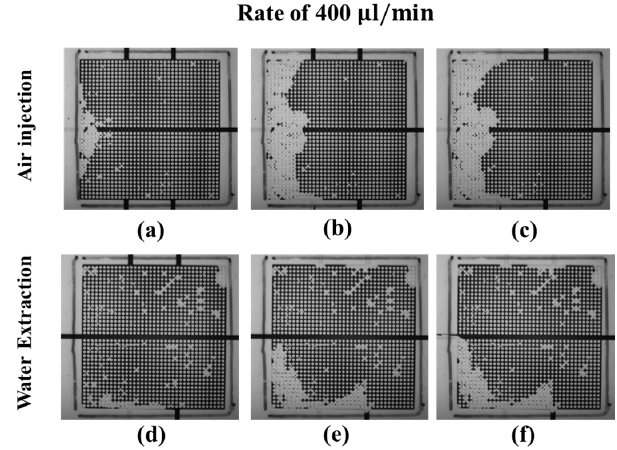
Figure 10. Dynamics of the water (dark)–air (transparent) distributions during the drainage process at an air-injection ( a – c ) and water-extraction ( d – f ) rate of 400 μ L/min in a micromodel comprising a narrow mainstream channel with a width of 1 mm; ( a , d ) correspond to the, ( b , e ) to the middle, and ( c , f ) to the end of the drainage process.